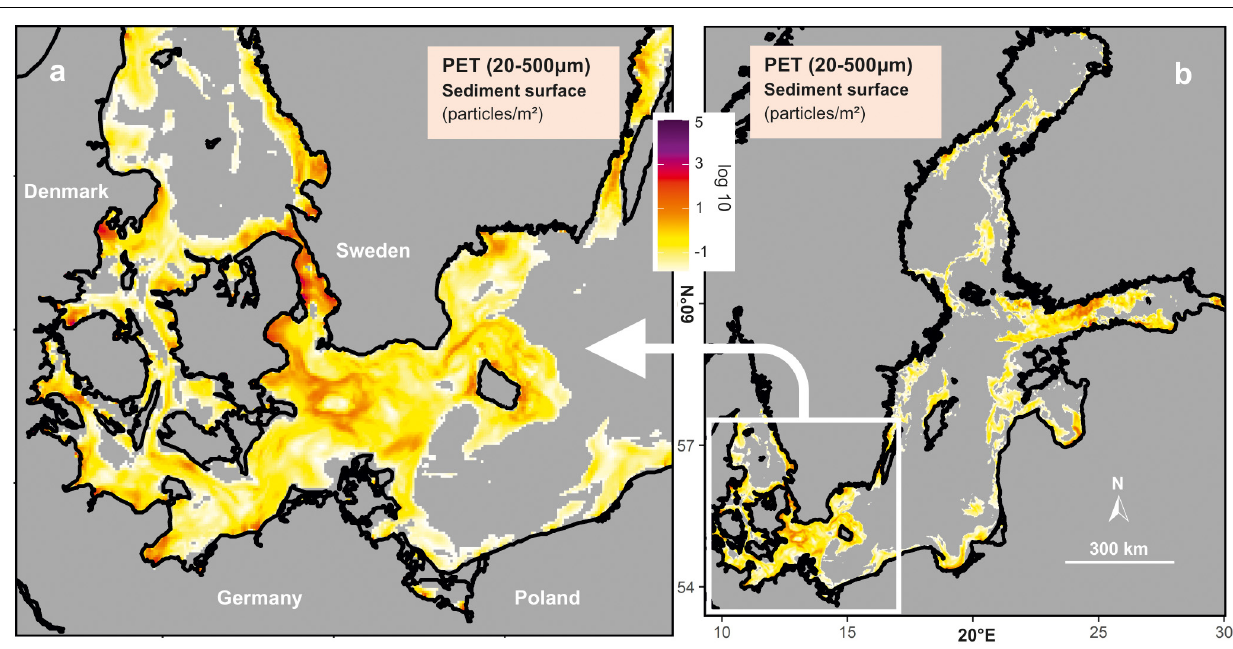
FIGURE 6 | Spatial concentration of Polyethylenterephthalat (PET) microplastic particles (20–500 µ m size fraction) at the sediment surface of the Baltic Sea (a) and in the western Baltic Sea (b) based on simulations with a 3D hydrodynamic model. PET represents sinking plastic. The emissions cover all three urban sources. Gray areas in the sea indicate concentrations below 0.01 particles/m 2